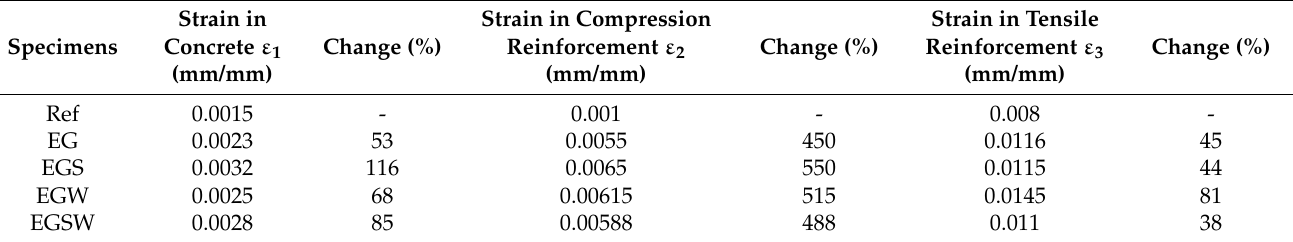
Figure 9. Load-strain relationships of concrete in compression zone at mid-span. Table 5. Maximum strain measurements in concrete and steel reinforcement.